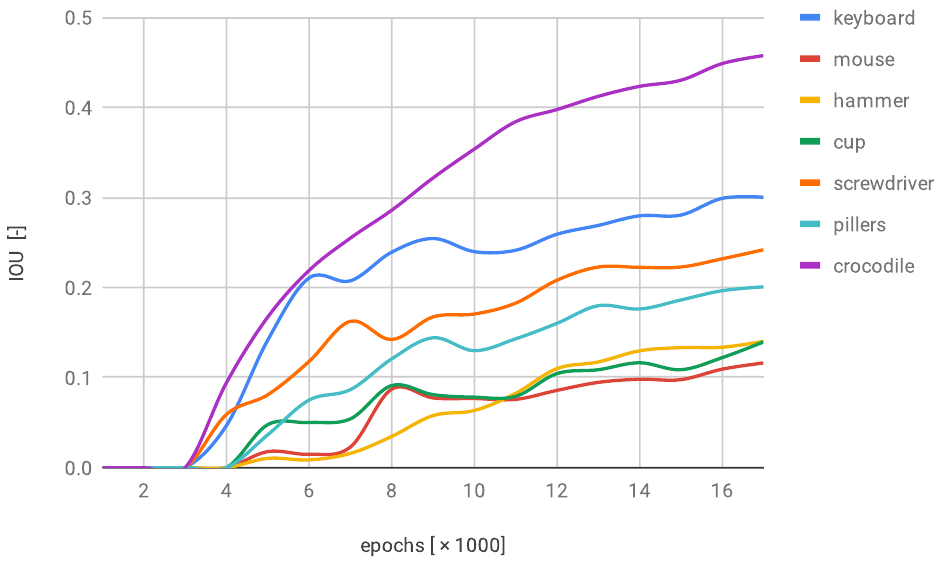
Figure 10. IOU changes over training progress on first modified dataset.